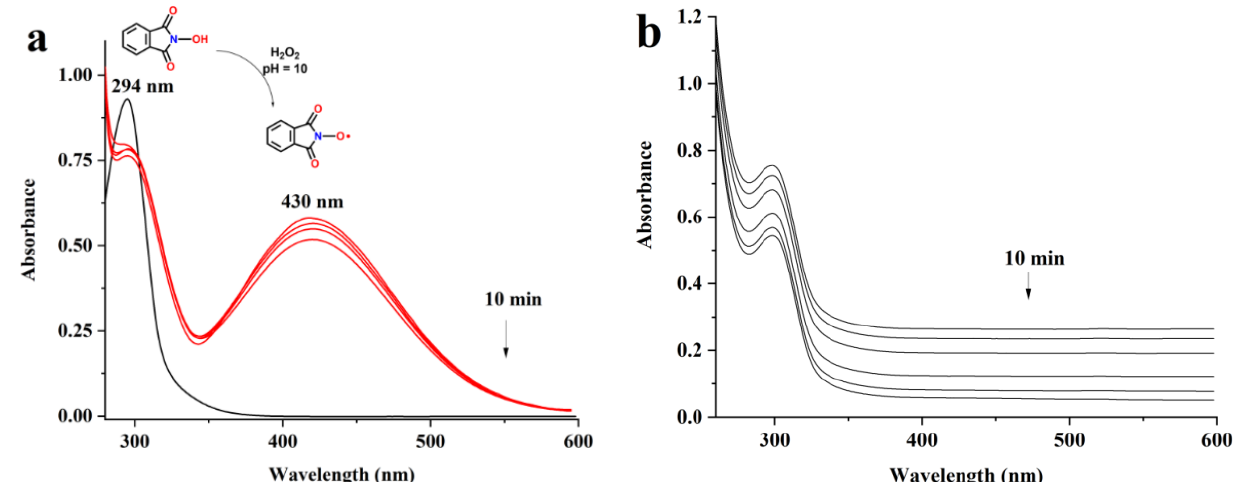
Figure 2. ( a ) UV/Vis absorption of NHPI (1 mM) and H 2 O 2 (100 mM), in acetonitrile/water 1:1 (vol) at pH 10. ( b ) UV/Vis absorption of a mixture of NHPI (1 mM) and H 2 O 2 (100 mM) in acetonitrile/water 1:1 (vol), without pH correction to 10.